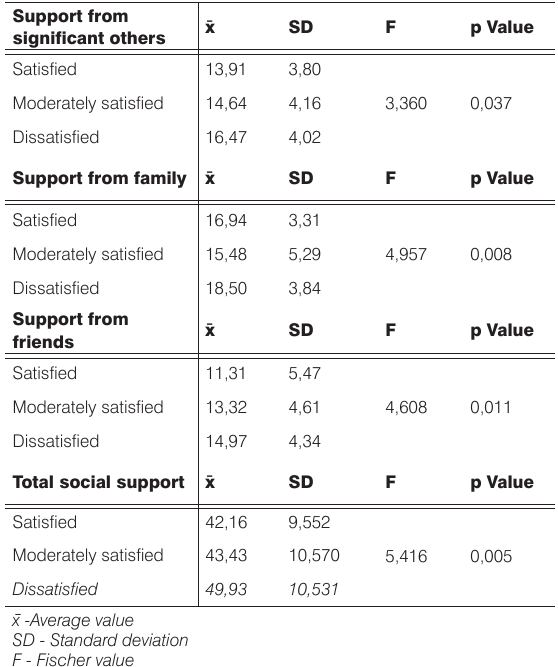
Table 4. The mean score values of the subscales and the total MSPSS comparing the observed subgroups of